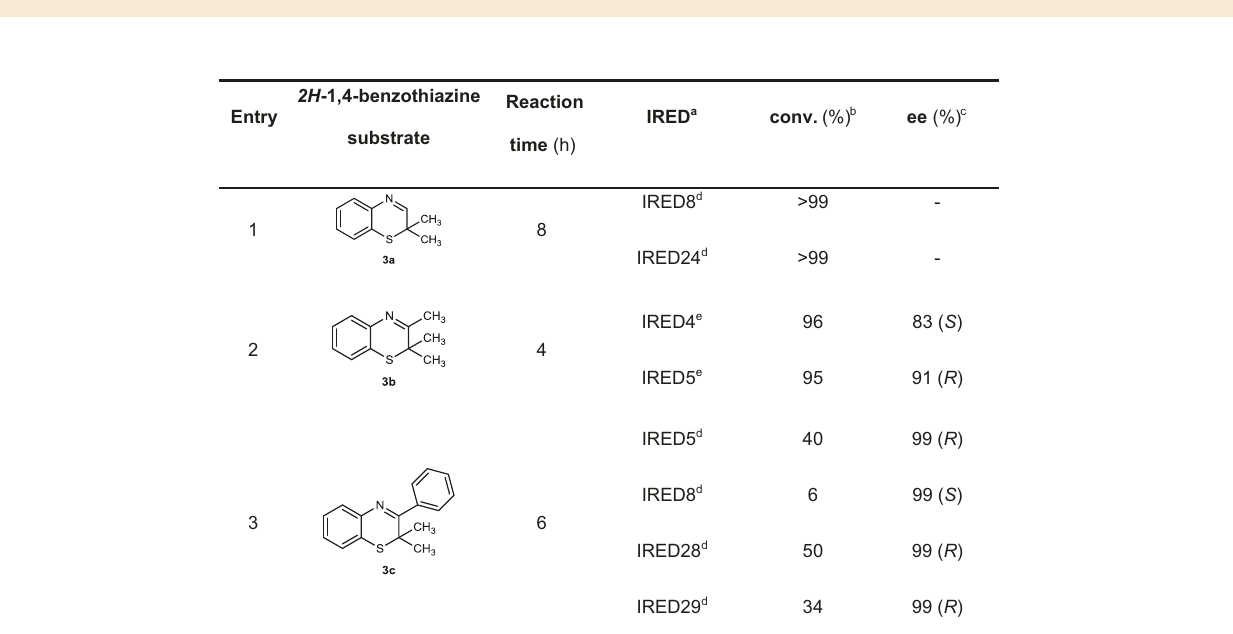
Table 2 Reduction of 2 H -1,4-benzothiazines using imine reductases (IREDs)